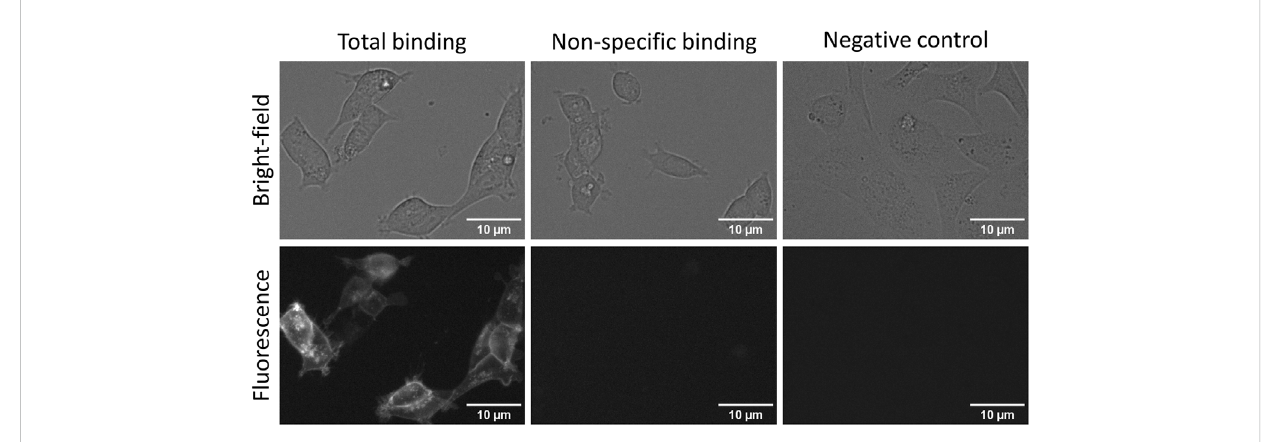
FIGURE 6 Fluorescence and bright- fi eld images of total (left panels) and non-speci fi c binding (central panels) of CELT-419 to live HEK293-D3R cells and to SKOV3 cells without D 3 receptors (right panels). HEK293-D3R cells in DMEM medium with added 9% FBS and antibiotic antimycotic solution were incubated with 2 nM CELT-419 in the absence (total binding) or presence (non-speci fi c binding) of 10 μ M Spiperone for 2 h in 5% CO 2 and at 37 ° C. The number ofseededcellsper wellwas20,000. Fornegativecontrol,SKOV3 cellswithoutD 3 receptorsseeded at30,000cellsper wellwereusedwith 2 nM CELT-419. The contrast of fl uorescence and bright- fi eld images was enhanced for presentation purposes only, thesame lookup table wasused for all images of the same imaging mode. The scale bar corresponds to 10 μ m.